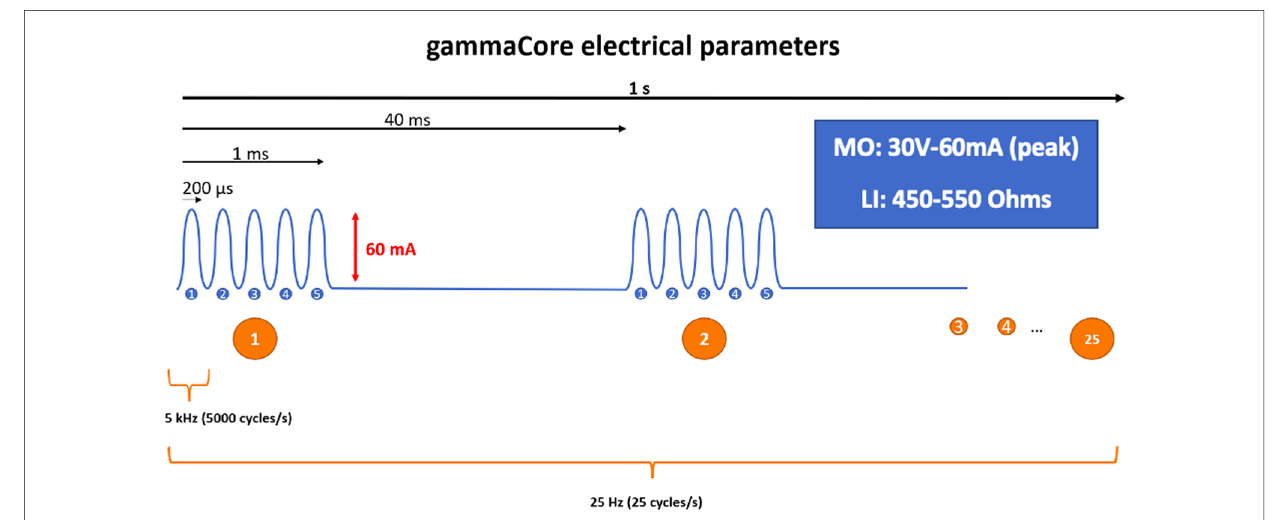
FIGURE 1 Schematic representation of the electrical parameters of the gammaCore device: 5 kHz sine wave burst lasting for 1 ms ( fi ve sine waves, each lasting 200 μ s), repeated once every 40 ms (25 Hz), generating an output of 60 mA at 30 V. LI, load impedance; MO, maximum